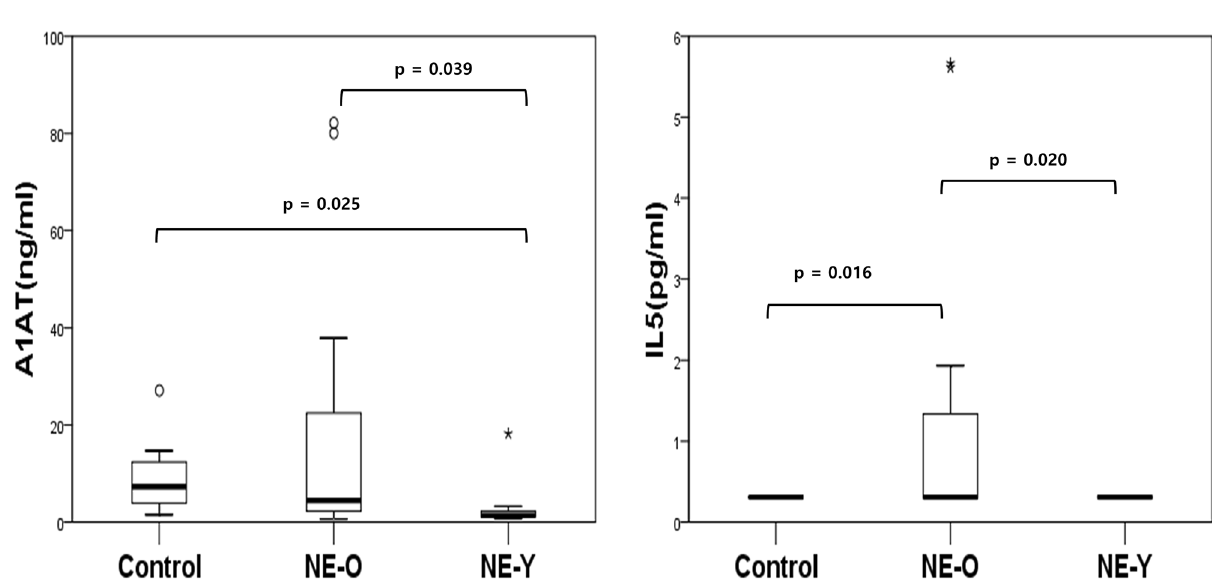
Figure 3. Inflammatory mediators in NE-O and NE-Y. Data were evaluated by Kruskal–Wallis test and Dunn multiple comparison test. Bars indicate p < 0.05 after post hoc Dunn’s test. NE-Y: Non-eosinophilic polyp with age under 35 years, NE-O: Non-eosinophilic polyp with age over 35 years, A1AT: Alpha 1